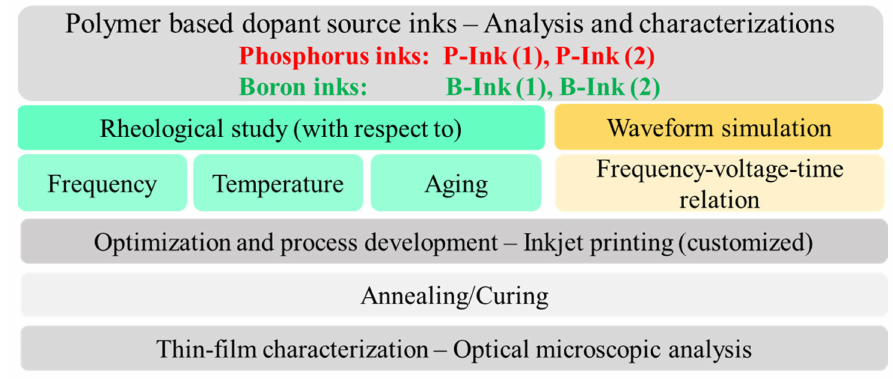
Figure 3. Experimental steps conducted in this work. Table 1. Classification of polymer-based dopant source inks in alcoholic